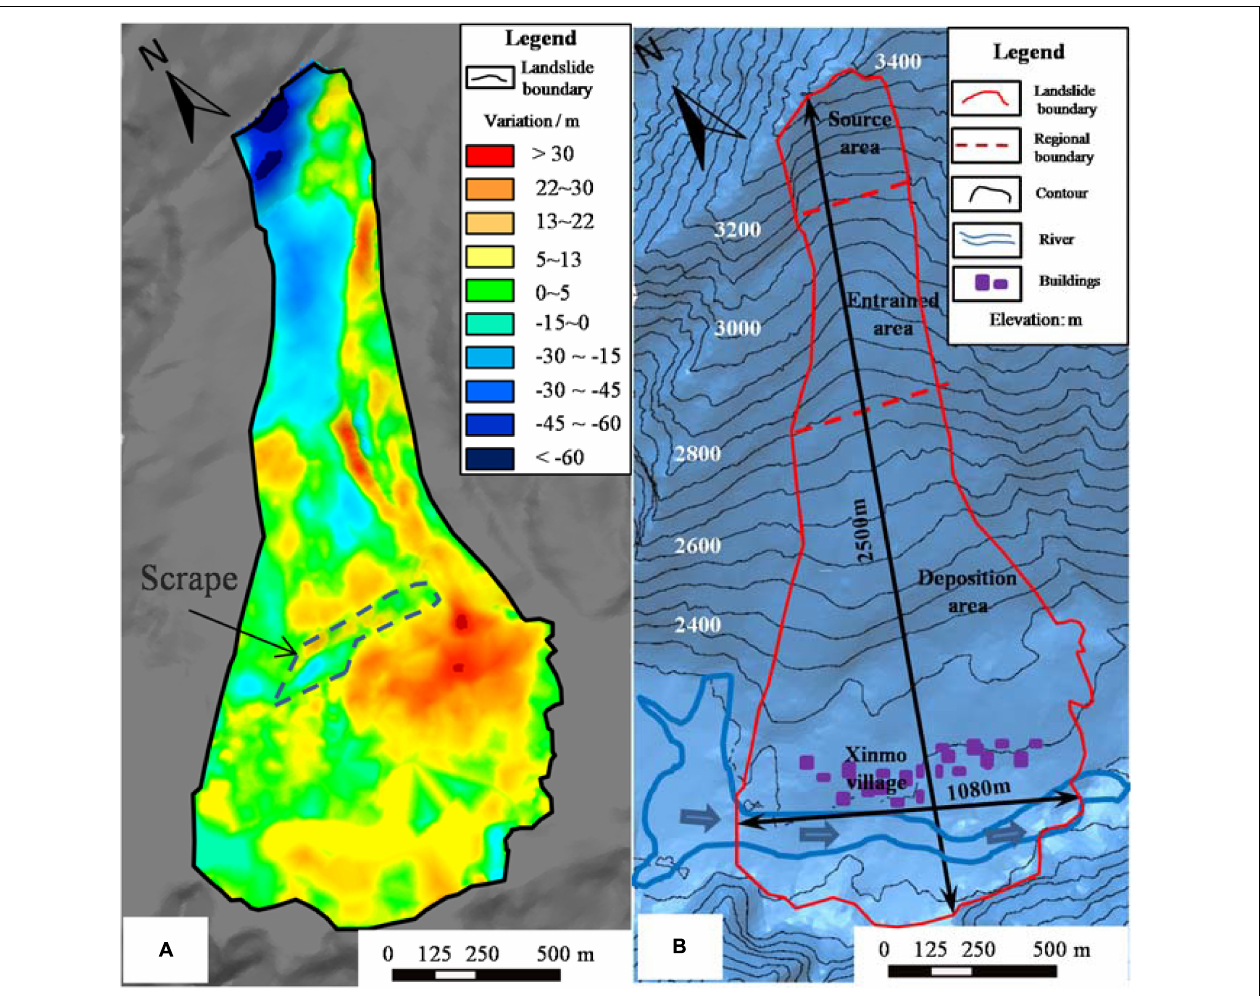
FIGURE 3 | Terrain conditions of the Xinmo catastrophic landslides: (A) elevation variation map of the Xinmo Landslide. Positive values indicate the thickness of deposit and negative values indicate reduction of surface elevation due source rock mass failure and entrainment of path materials. (B) digital elevation model of the Xinmo catastrophic landslide after